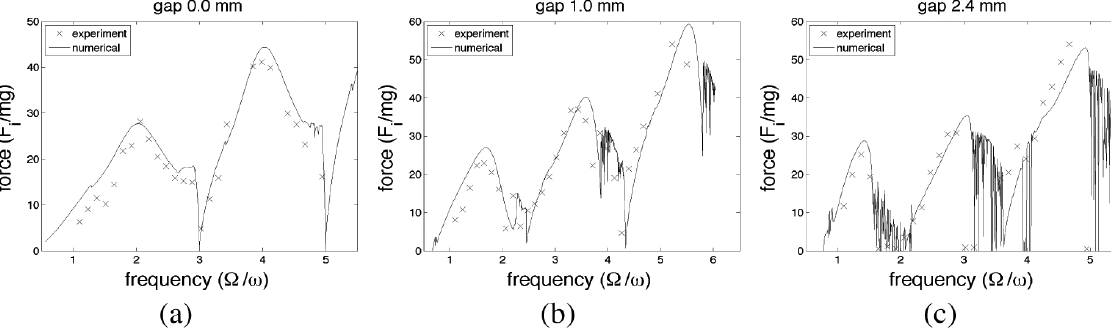
Fig. 11. Comparison between numerical simulation and experimental results. Non dimensional force versus non dimensional frequency. a) Gap 0.0 mm; b) Gap 1.0 mm; c) Gap 2.4 mm. x exc = A 0 sin(Ω t )